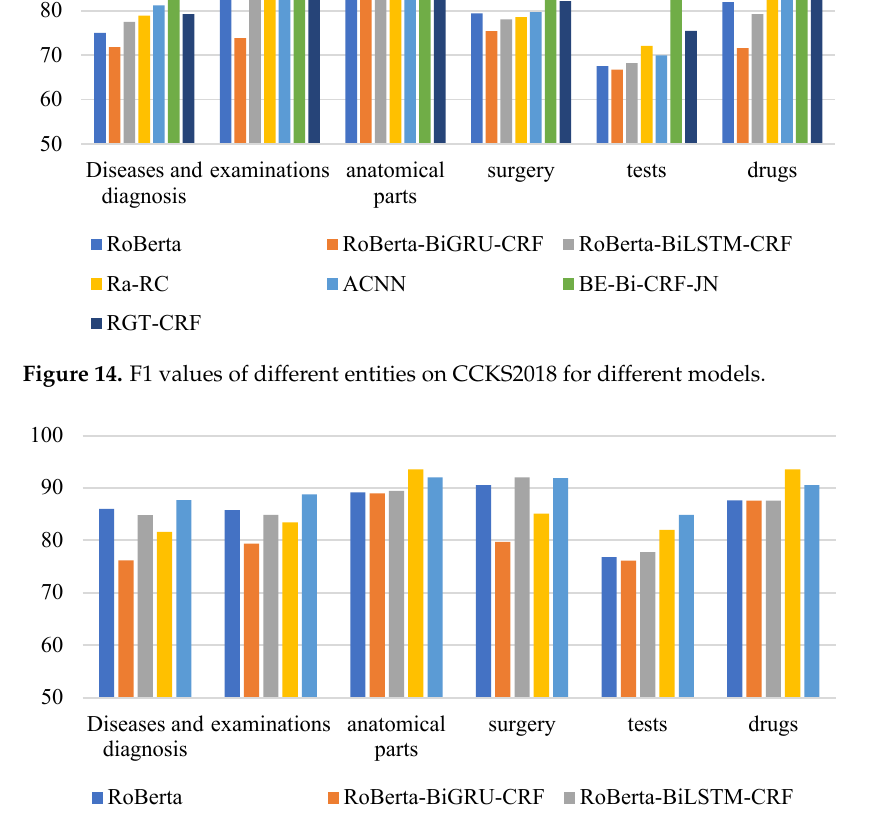
Figure 15. F1 values of different entities on CCKS2020 for different models.